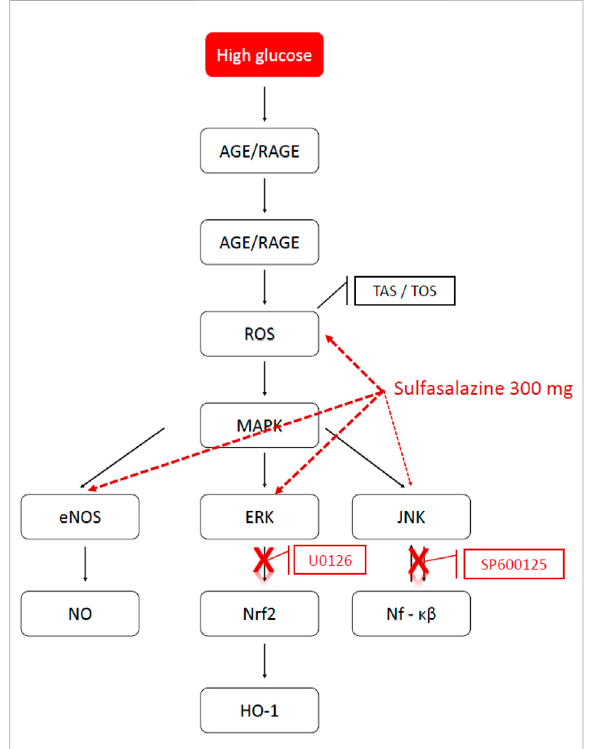
FIGURE 9 Possible pathways of action of sulfasalazine in high glucose. The possible pathways of action of sulfasalazine on endothelial dysfunction induced by high glucose. AGE, advanced glycation endproduct; RAGE, the receptor for advanced glycation endproduct; ROS, reactive oxygen speices; MAPK, the mitogen- activating protein kinase; eNOS, endothelial nitric oxide synthase; NO, nitric oxide; ERK, extracellular signal-regulated kinase; JNK, Janus kinase family; Nrf2, nuclear factor erythroid 2-related factor 2;Nf-kB,nuclearfactor “ kappa-light-chain-enhancer ” ofactivated B-cells; HO-1, Heme oxygenase; U0126, ERK inhibitor; SP600125, JNK inhibitor (Prepared on 11.06.2018 using the website